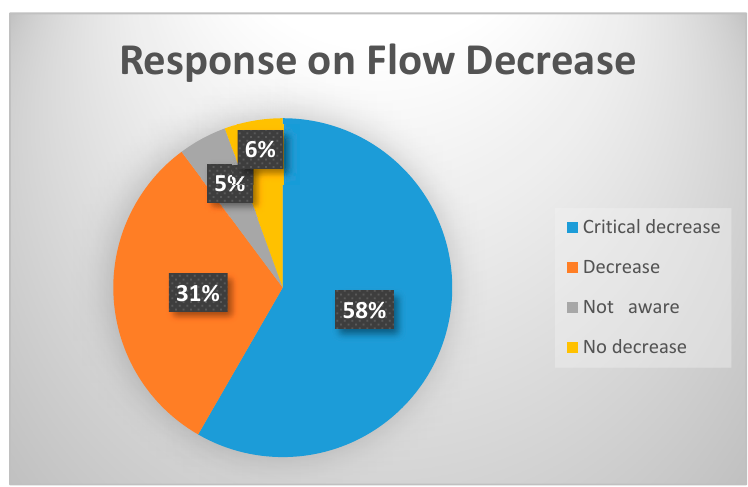
Figure 3. Respondents’ response percentages on the flow decrease.